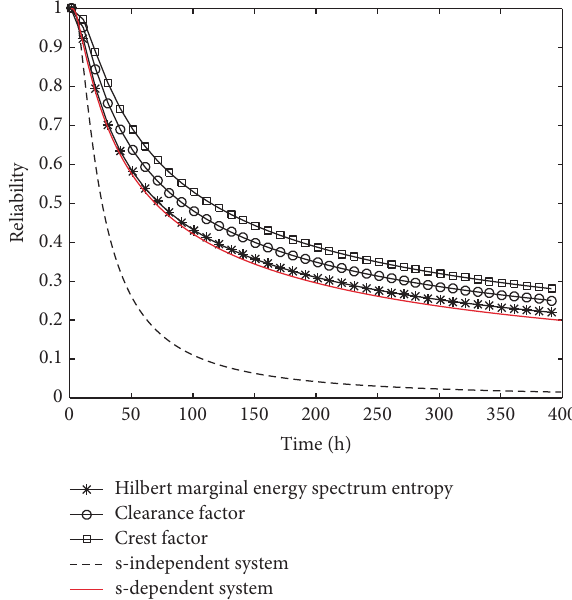
Figure 10: Comparison of the system